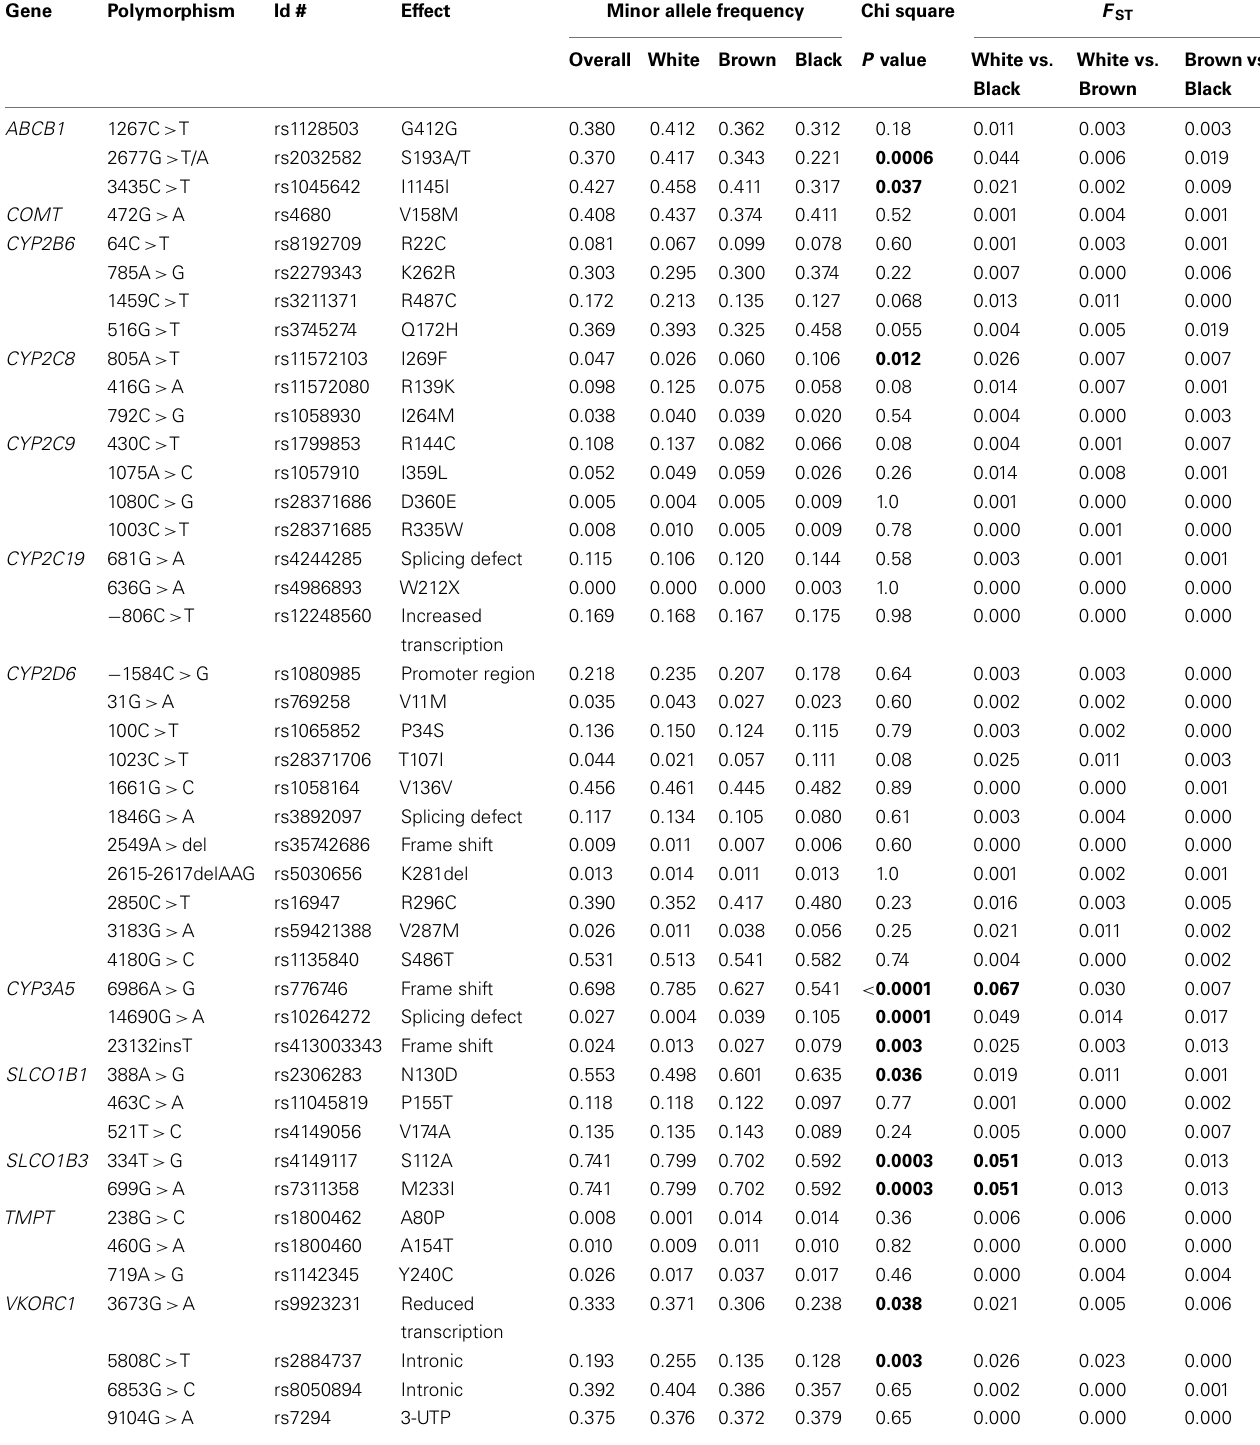
Bold numbers in the column “chi square” indicate statistically significant P values; bold numbers in the “White vs. Black” column indicate moderate pharmacogenetic